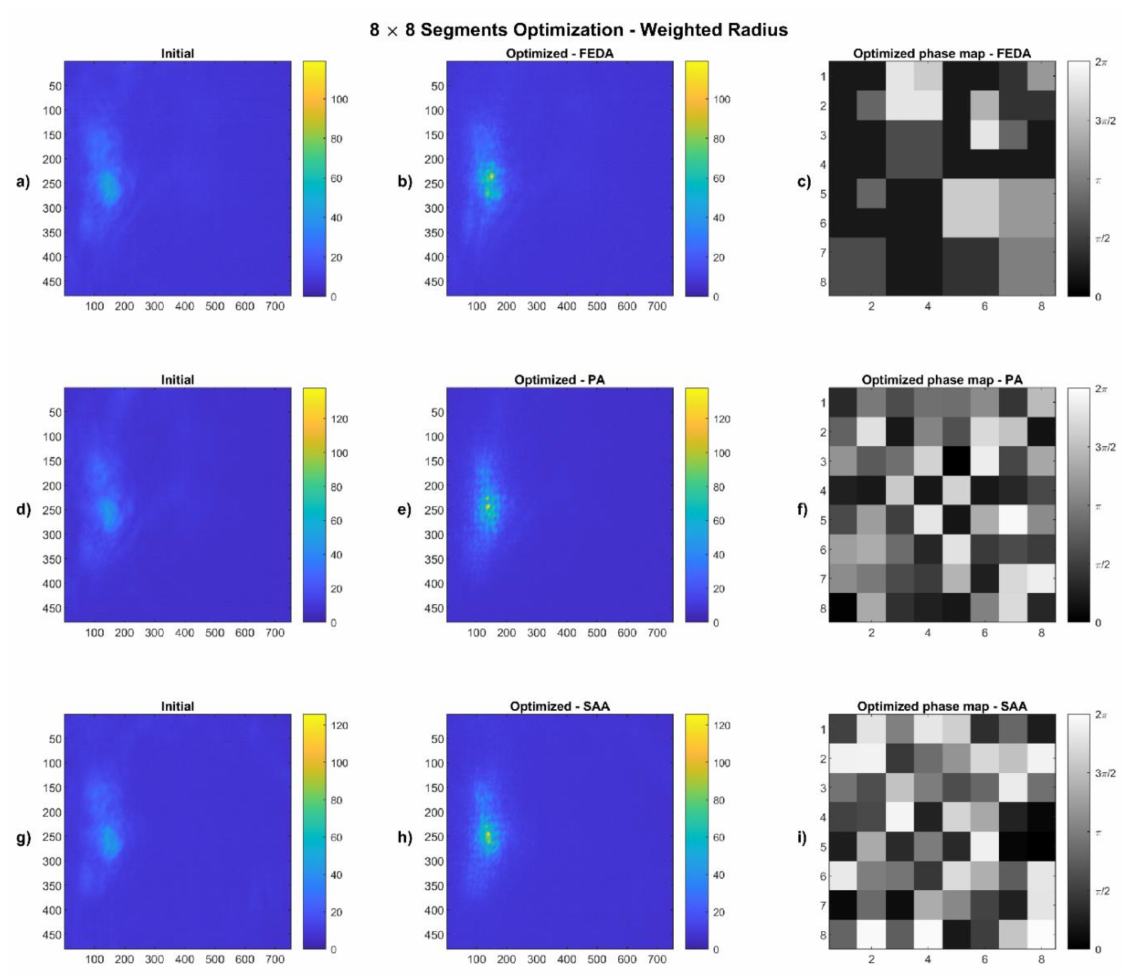
Figure 11. Results for the 8 × 8 segmentation of the phase map with the weighted radius being the cost function. ( a , b ), ( d , e ), ( g , h ) stand for the initial and optimized intensity distributions captured by the CMOS when running FEDA, PA, and SAA algorithms, respectively. All initial’s intensity distributions were captured before running each algorithm and after setting the phase of the incident beam to zero. For the intensity distributions, the grid values correspond to pixel units of the CMOS, and the colorbar/intensity range can have values in between 0–255. ( c , f , i ) are the achieved optimal phase maps/matrices projected in the SLM after running FEDA, PA, and SAA, respectively. For the phase maps, its values range from 0 (black) to 2 π (white) with 10 values in between this